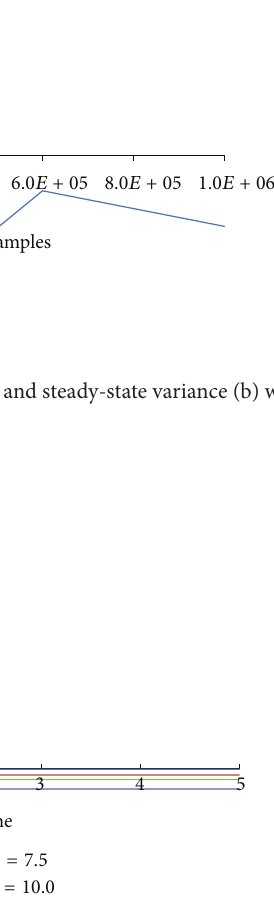
Figure 6: Convergence rate for different values of the nonlinearity strength 𝜆